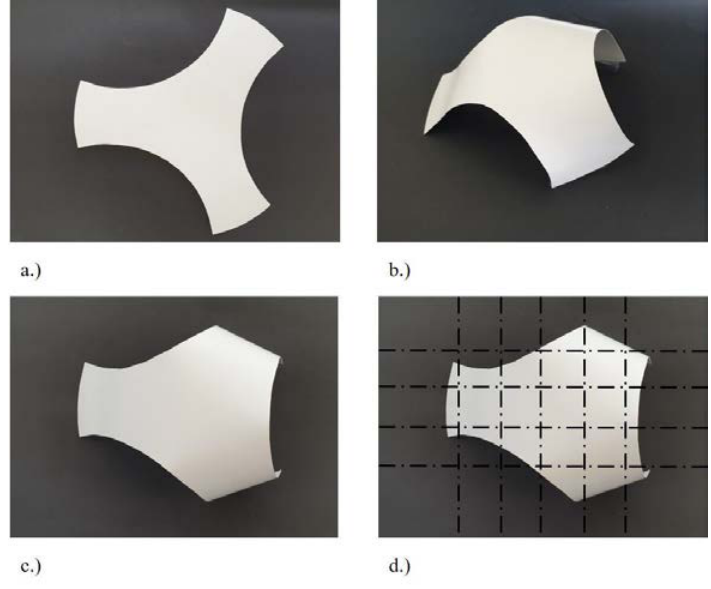
Fig. 8 Design concept as paper model.